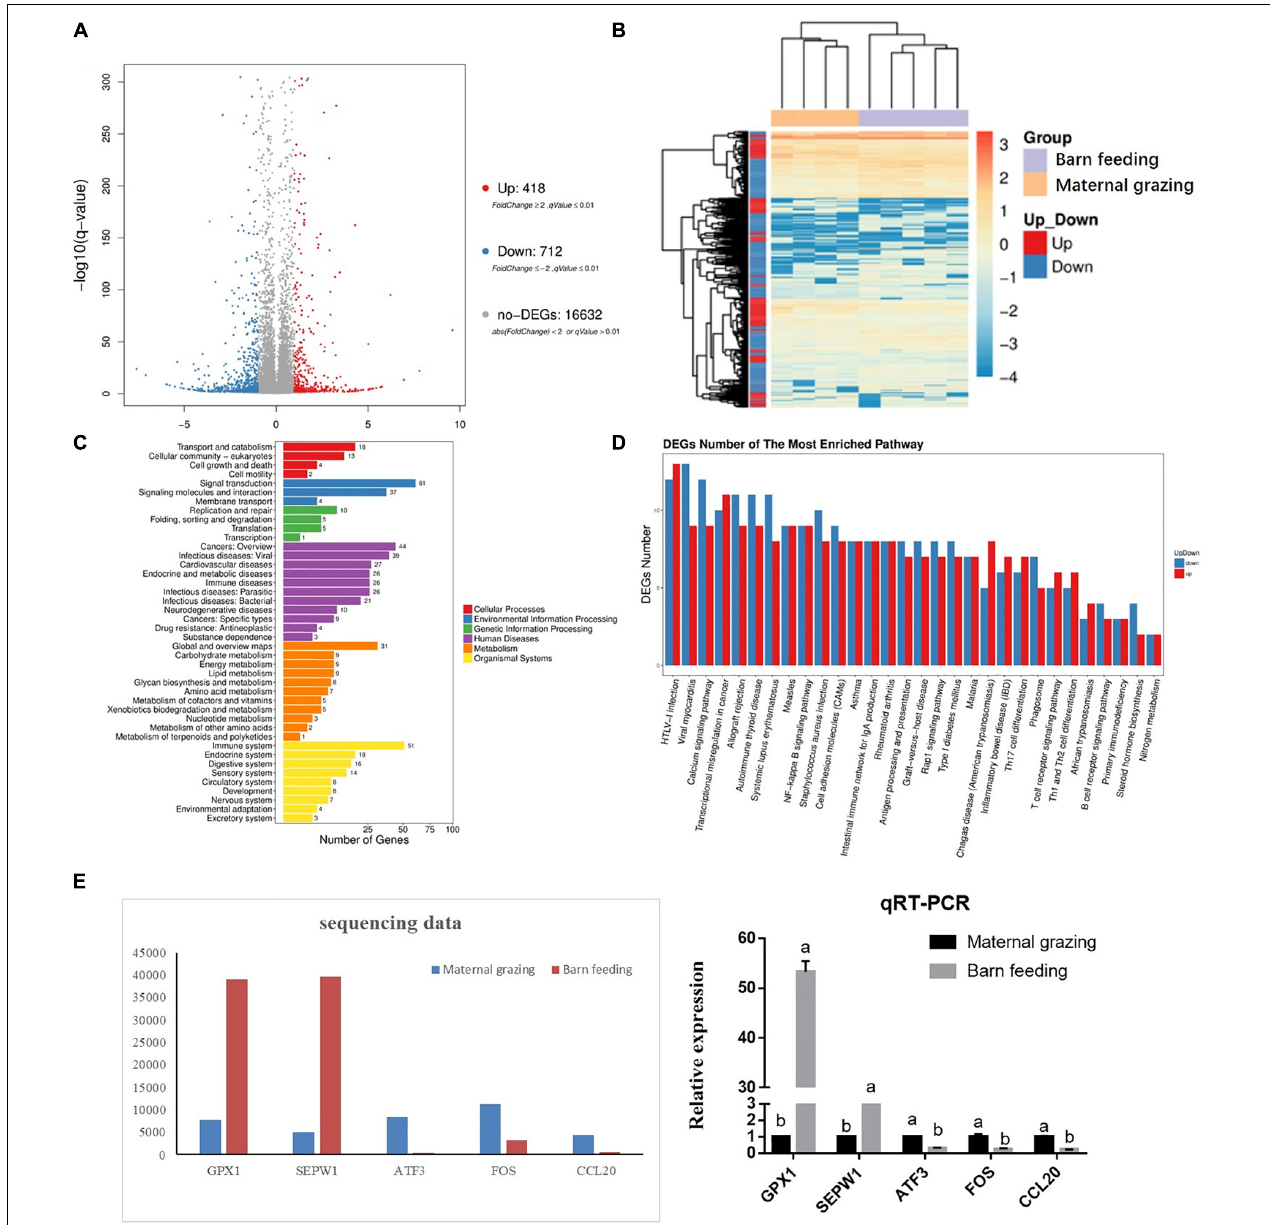
FIGURE 1 | Differentially expressed mRNAs in the rumen epithelium of yak calves from two different feeding strategies (maternal grazing and barn feeding) groups. (A) The volcano plot shows the significantly differentially expressed genes (barn feeding group vs maternal grazing group). (B) The heatmap of significantly differentially expressed genes. (C) Pathway classification based on the differentially expressed genes between the barn feeding group and maternal grazing group. (D) Significantly enriched pathways based on differentially expressed genes between the barn feeding group and maternal grazing group. (E) Sequencing of five selected DEGs verified by